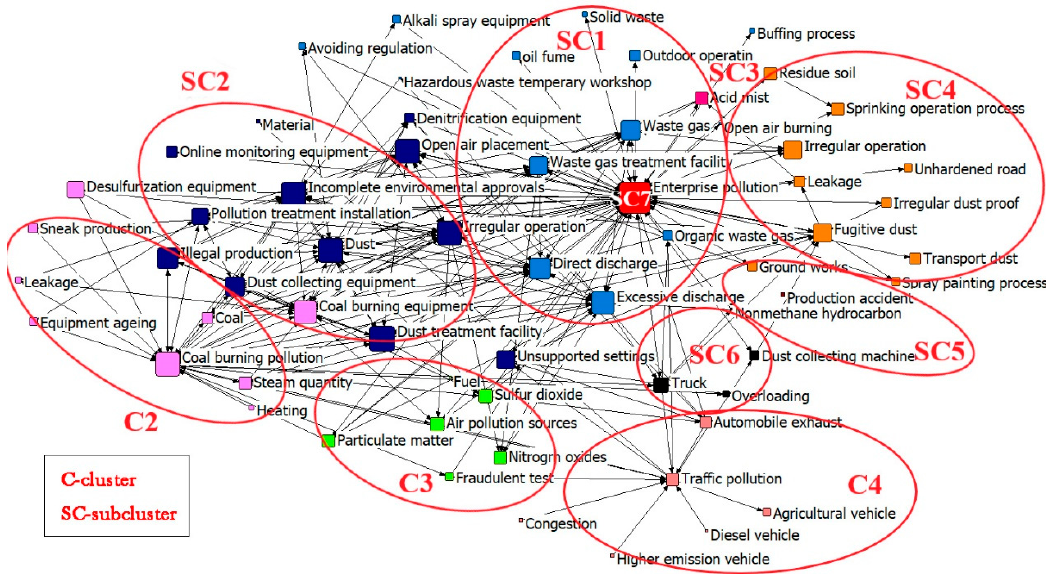
Figure 6. Visualization map based on MDS and node centrality.